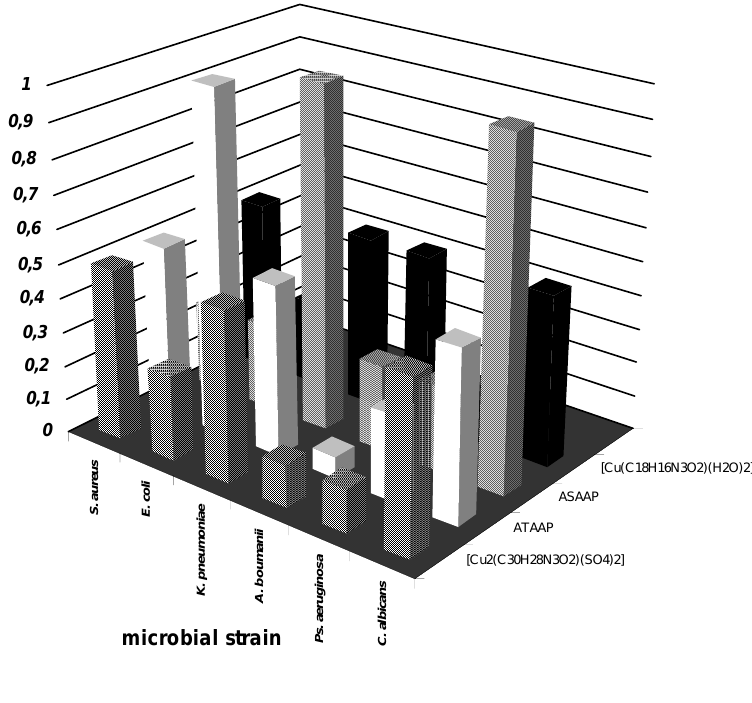
Figure 7 . The graphic representation of the MIC values (mg/mL) of the tested compounds towards different bacterial